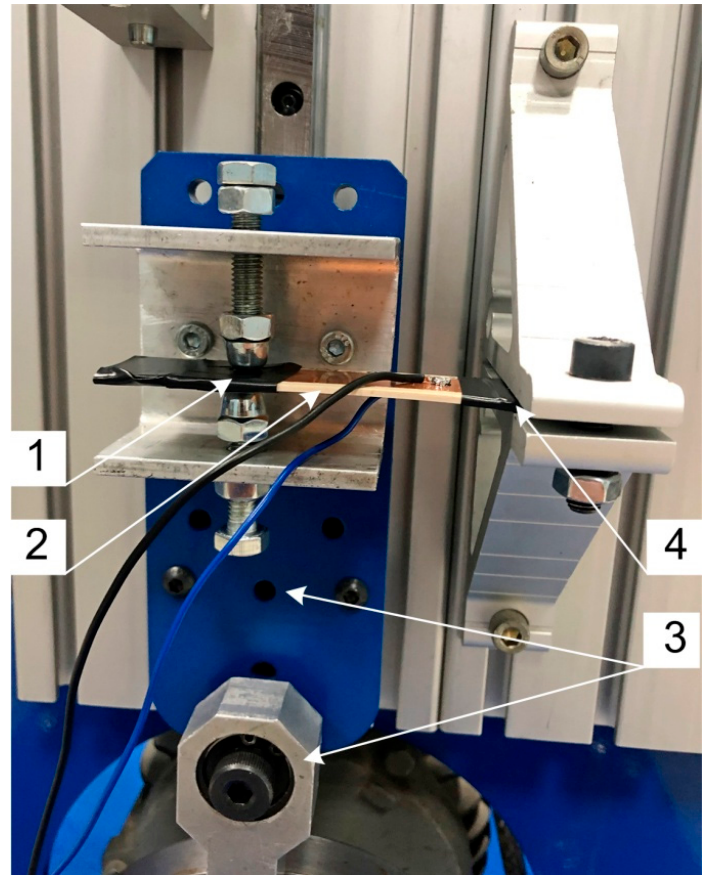
Figure 6. Laboratory setup used in laboratory research: 1—moving end of the composite beam, 2— particulate composite beam, 3—vibration generation system, 4—stationary end of the composite